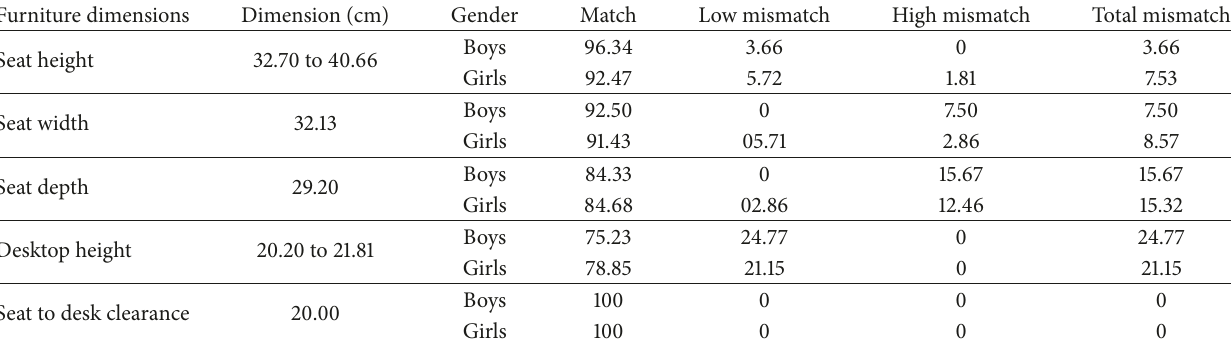
Table 6: Mismatch percentages of the proposed furniture dimension. Furniture dimensions